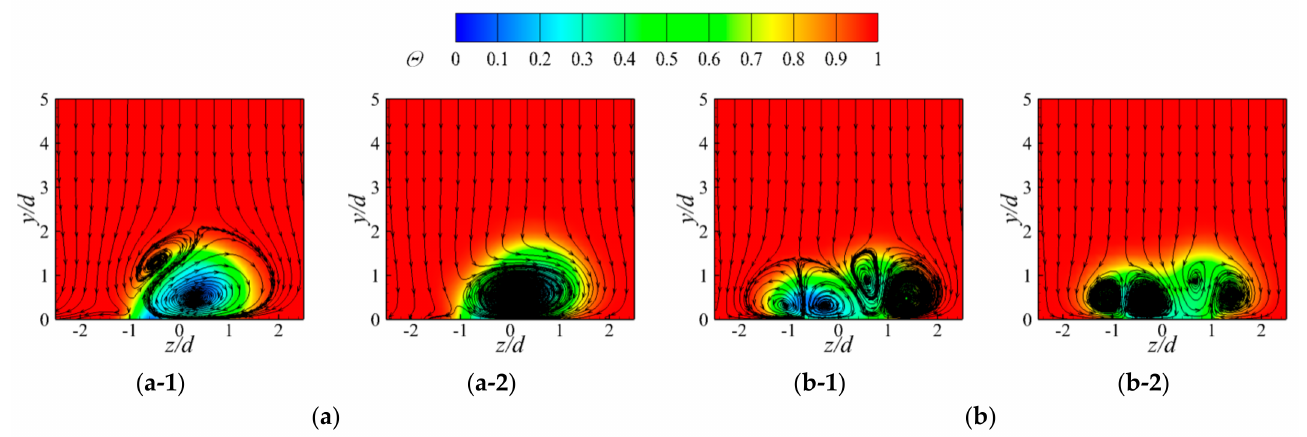
Figure 10. Dimensionless temperature contours and streamlines in downstream normal sections on the pressure side for two typical situations under M = 1.5. ( a ) Z / d = 0, β = 29 ◦ , ( a-1 ) s / d = 3,